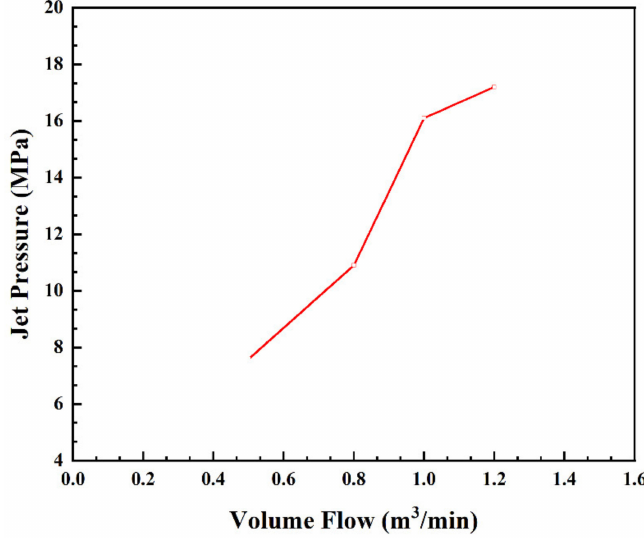
Figure 20. Variation in jet pressure at the well wall under different volume